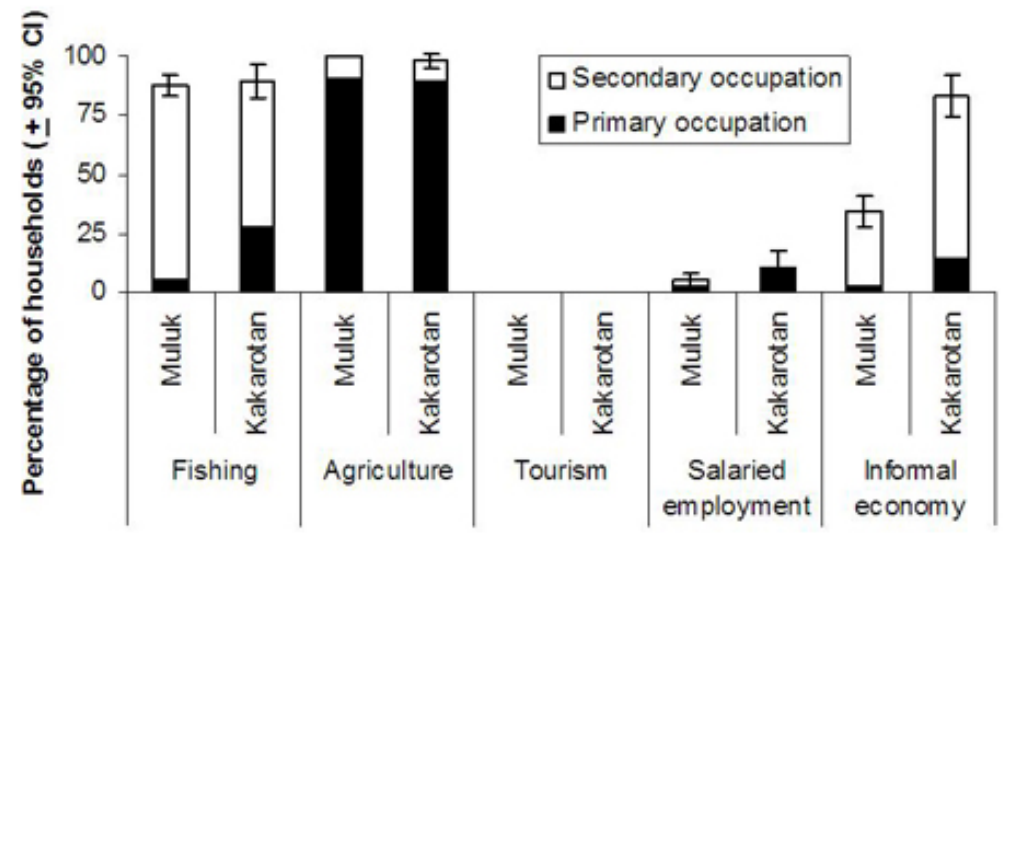
Fig. 2 . Distribution of occupations in Muluk and Kakarotan, highlighting the proportion engaged as a primary